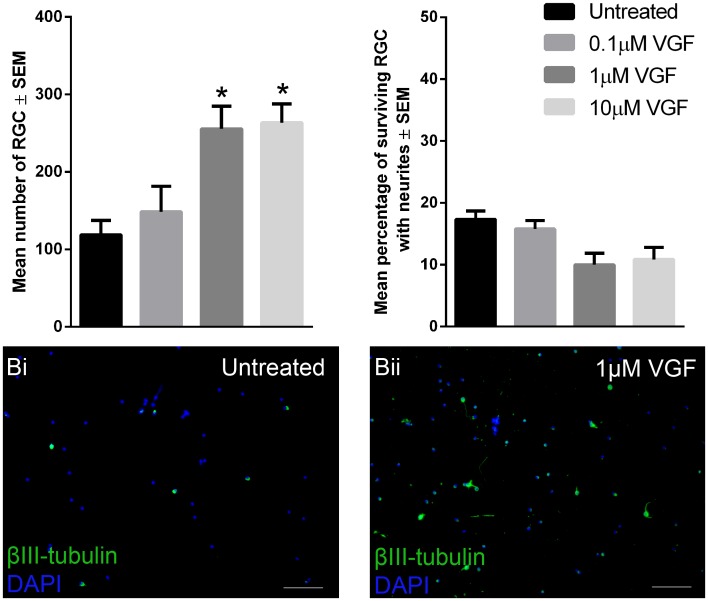
The effects of VGF on RGC in retinal cultures.The total number of surviving RGC as well as the percentage of RGC bearing neurites either cultured alone, or with 0.1 µM, 1 µM and 10 µM VGF (A). Asterisks indicate significant difference from other treatment groups at p<0.05. RGC cultured either alone (Bi) or with 1 µm VGF (Bii). All images are representative of the entire culture, nine separate culture wells/treatment with every three wells using different animals (scale bars: 100 µm), cell nuclei were stained with DAPI.